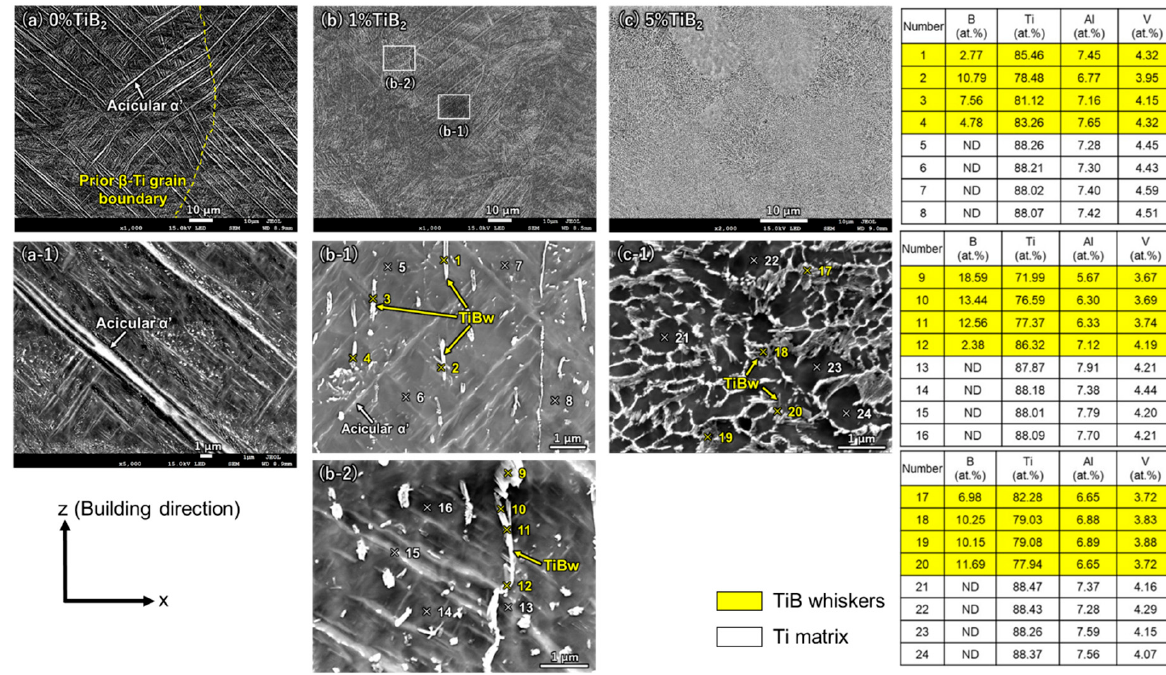
Figure 5. EDS analysis of SLM Ti64- ( a ) 1 and ( b , c ) 5 mass% TiB 2 alloys: (-1) inside prior β -grains and (-2) on prior β -grain boundaries.